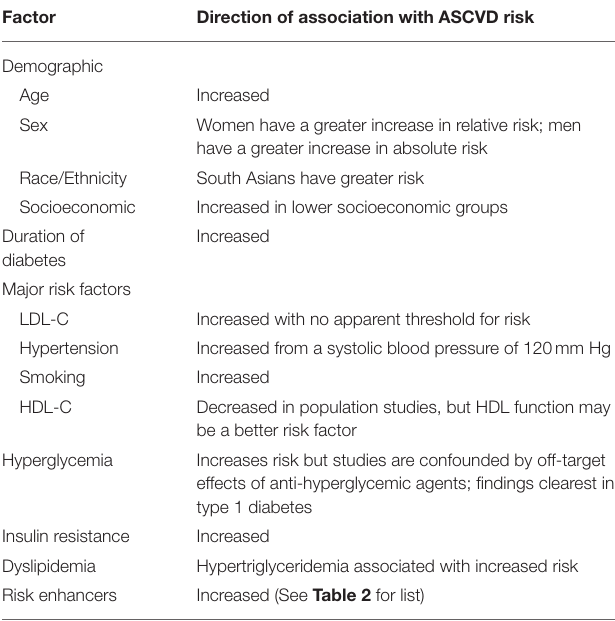
TABLE 1 | Known associations between demographic, clinical and cardiometabolic risk factors and increased atherosclerotic cardiovascular disease (ASCVD) risk in